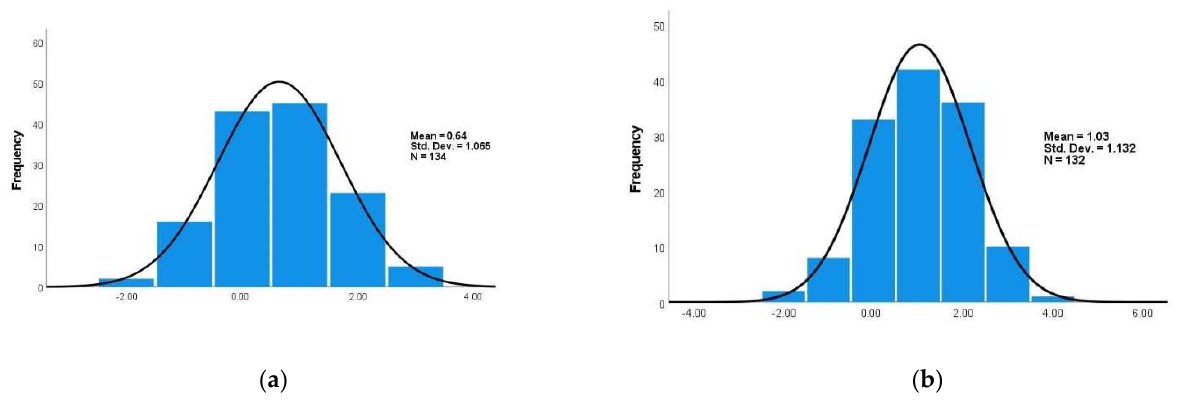
Figure 4. Changes (impact of the course) in estimates of how the results of market and profitability analysis affect the (initial) business concept. ( a ) University A; ( b ) University B.